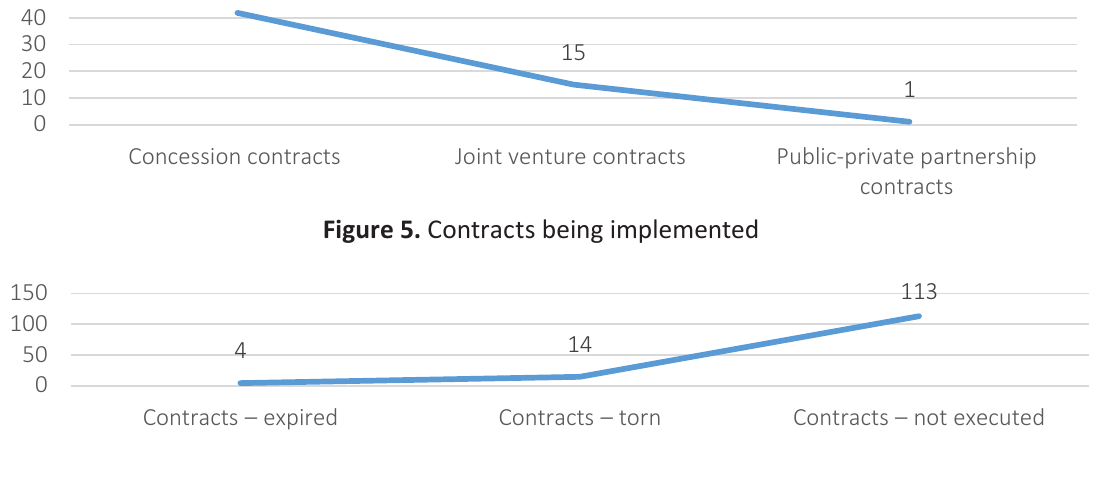
Figure 6. Contracts not